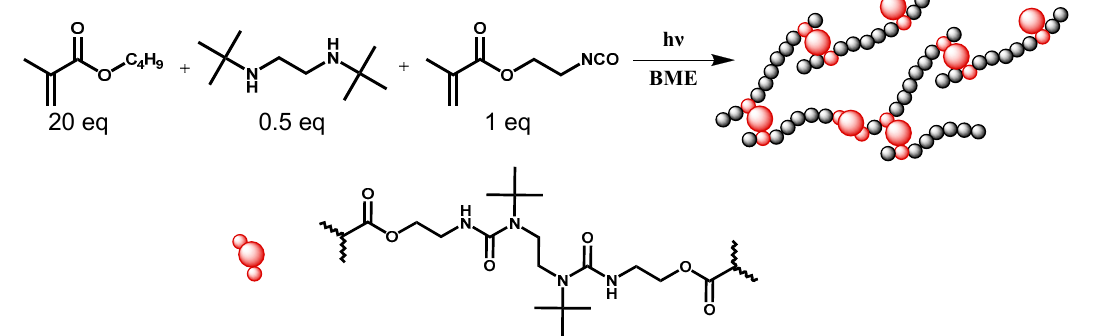
Scheme 1. Schematic representation of the synthesis of the polymer network using a photo polymerization process with benzoin methyl ether (BME) as initiator and light between 320 and 520